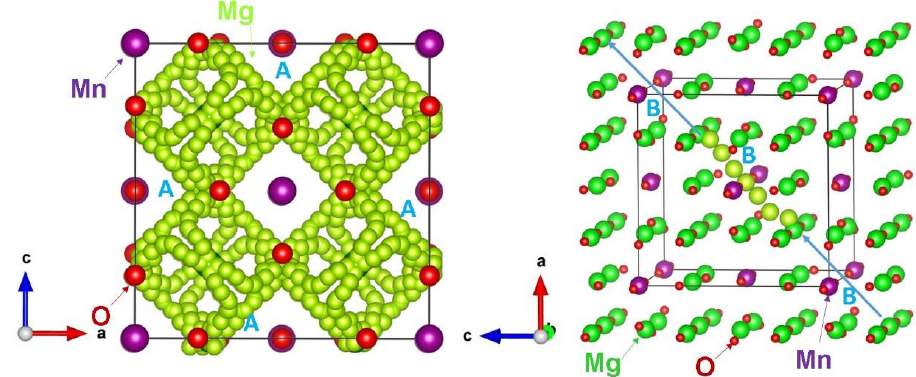
Figure 3. Possible long-range magnesium vacancy migration paths considered. Table 2. Calculated Mg–Mg separations and activation energies for the magnesium ion diffusion between two adjacent Mg sites (refer to Figure 3).